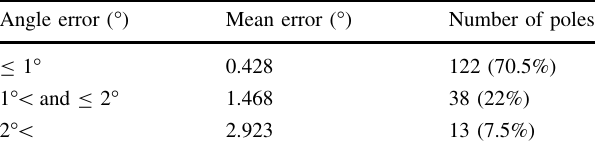
Table 3 Distribution of angle differences of the 173 utility poles in the Beaumont, Texas, case study site Angle error ( (cid:3) )